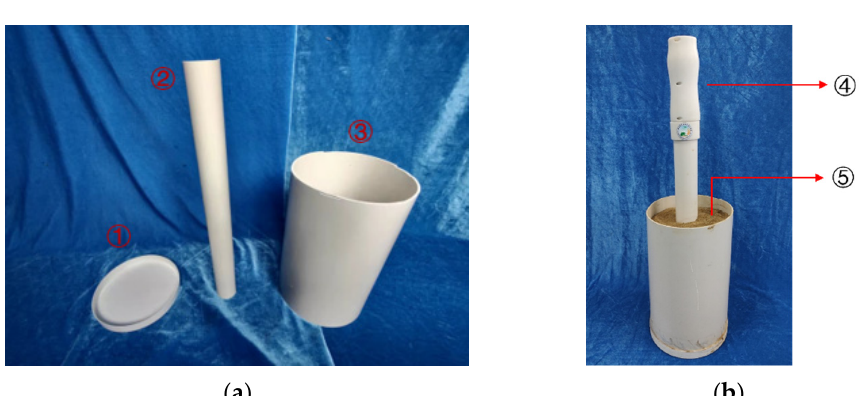
Sensors 2023 , 23 , x FOR PEER REVIEW 13 of 22